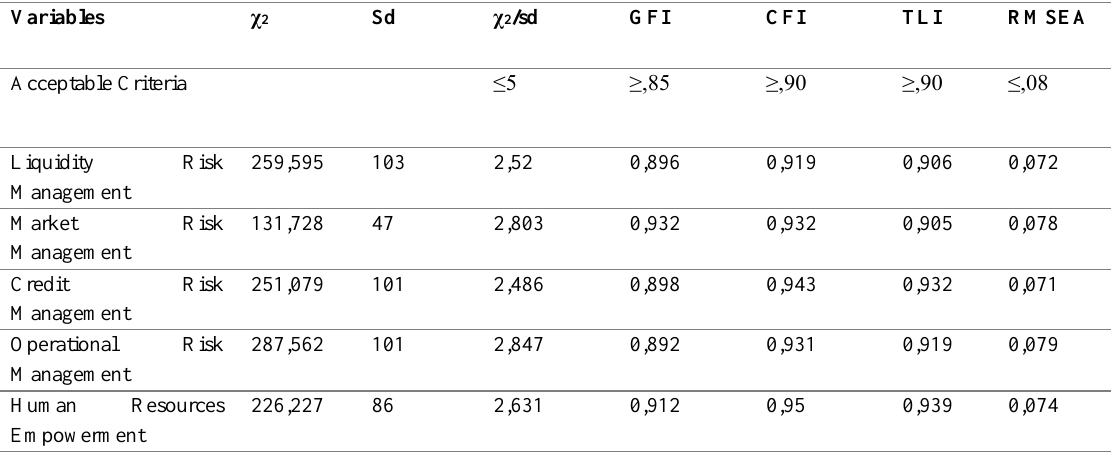
Table 3: CFA Goodness of fit Values